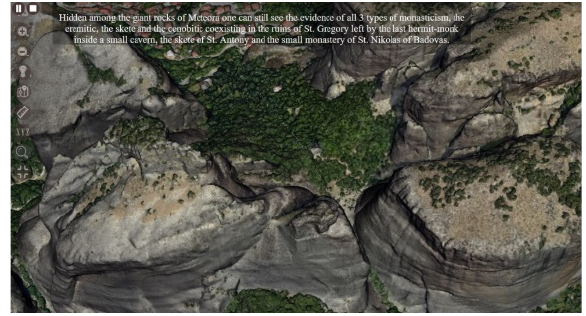
Figure 7. Screenshot from supervised navigation in the Meteora site via the METEORA platform